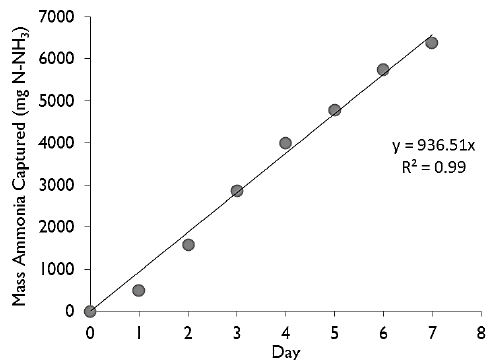
Figure 2. Representative time series of NH 3 capture within the sulfuric acid (receptor) per day. Results from digestate (donor) with an initial TAN concentration of 1860 mg·L − 1 , initial pH of 7.7, and an initial temperature of 23.7 °C. The slope is taken as the capture rate (937 mg NH 3 ·day − 1 ).